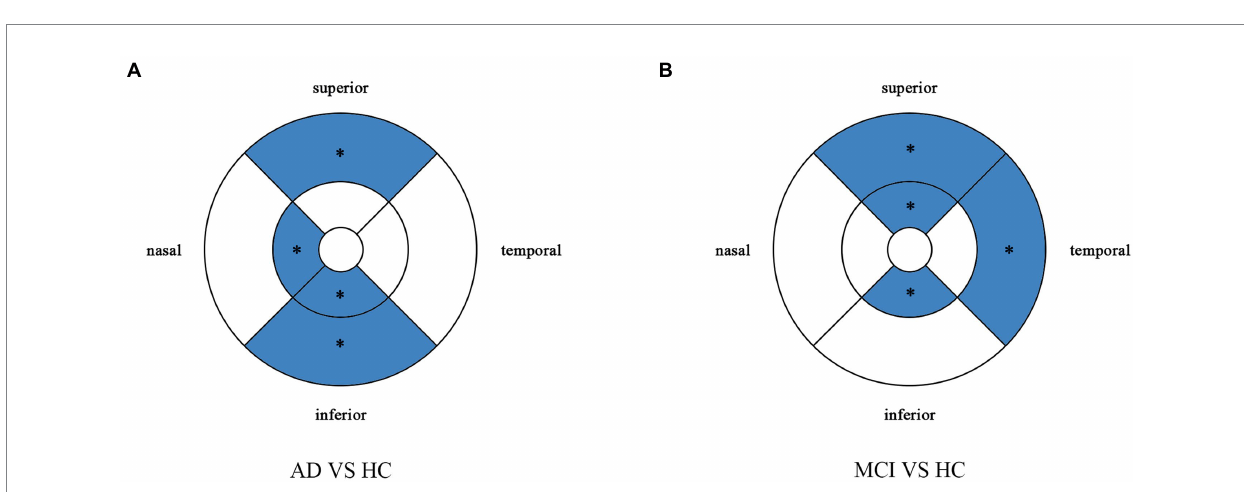
FIGURE 3 Multiple logistic regression was used to assess the association between retinal vessel density and clinical diagnosis, adjusted for confounders of sex, age, history of smoking, history of alcohol intake, hypertension, hyperlipidemia, BCVA, and IOP. Blue regions indicate decreases significantly compared with the HC group. (A) Compared with HC group, vessel density decreases significantly in the nasal and inferior regions of the inner ring and in the superior and inferior regions of the outer ring in the AD group. (B) Compared with HC group, vessel density decreases significantly in the superior and inferior regions of the inner ring and in the temporal and superior regions of the outer ring in the MCI group. *Significant at p < 0.05. AD, Alzheimer’s disease; MCI, mental cognitive impairment; HC, healthy